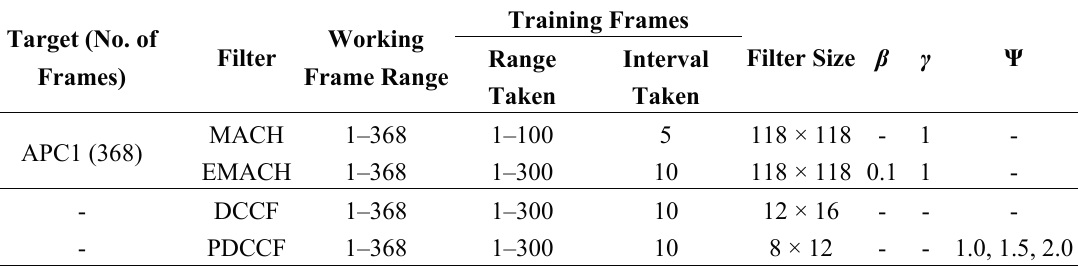
Table 3. Training data for Sequence